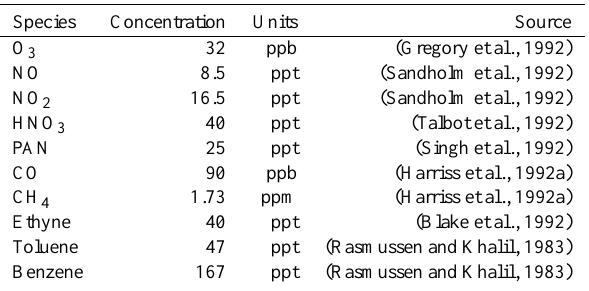
Table 2. Concentrations and sources used to initialize the RACM model. PAN is peroxyacyl nitrates. Any chemical species not listed but that is tracked by the model (for example, methyl vinyl ketone and methacrolein) were initialized to